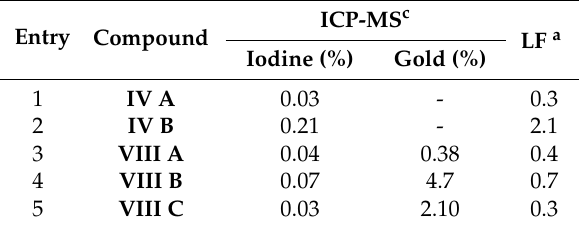
Table 2. ICP–MS analyses of IV A–B and VIII A–C